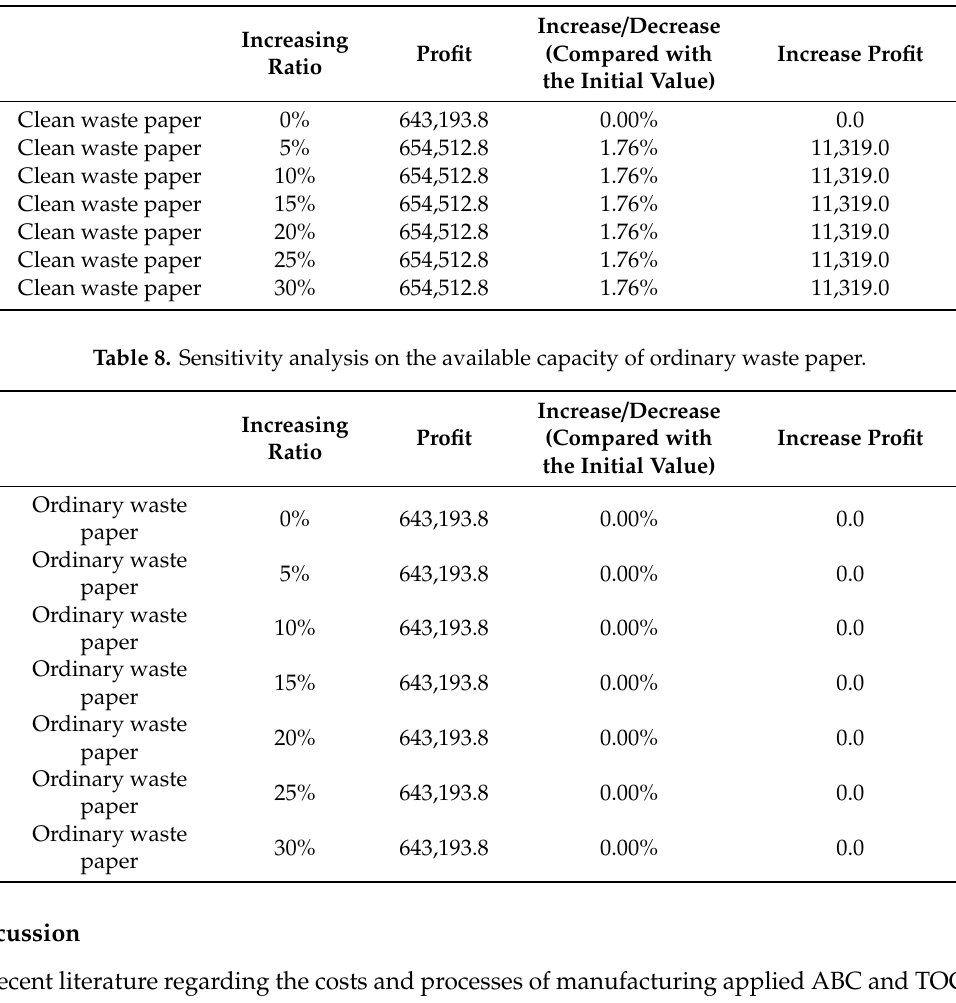
Table 7. Sensitivity analysis on the available capacity of clean waste paper.